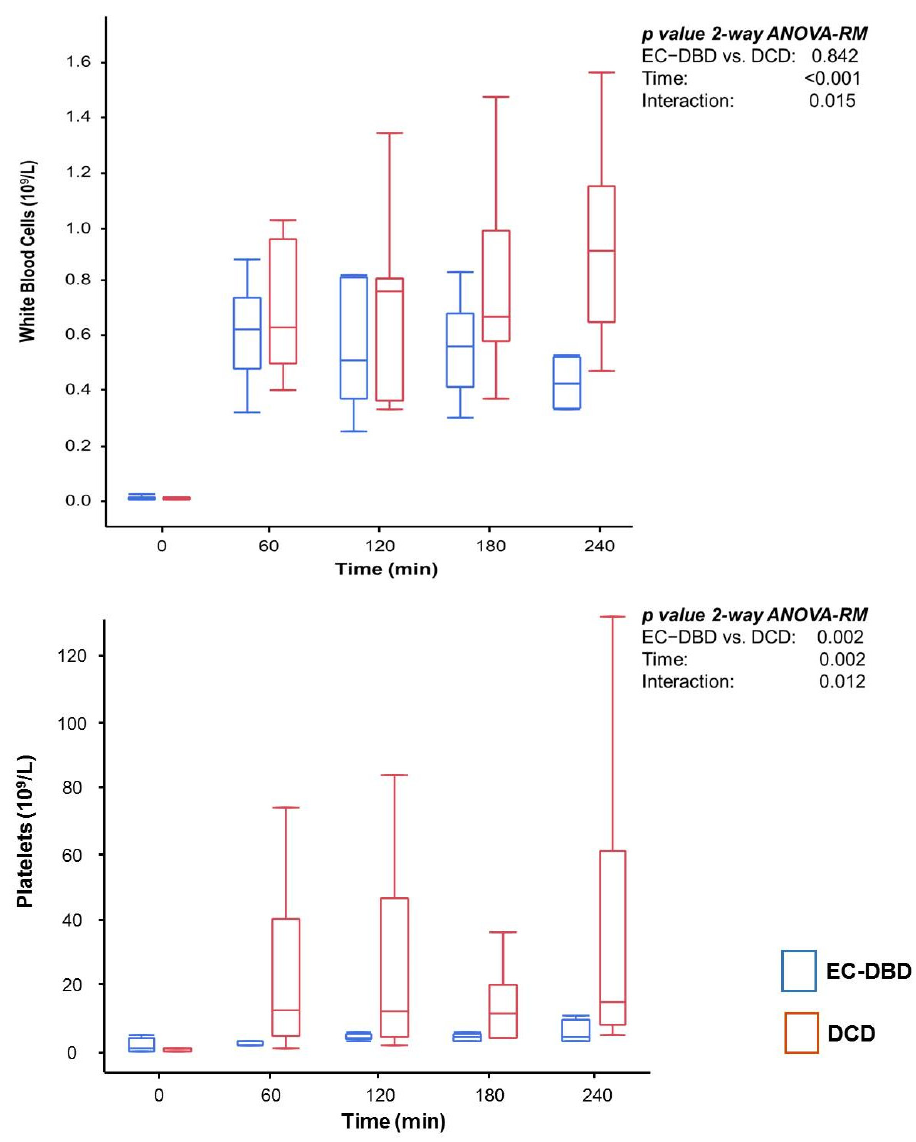
Figure 2. White Blood Cells and Platelets during EVLP. Appearance of white blood cells (WBC) and platelets in the EVLP perfusate of EC-DBD (blue) and DCD (red) grafts over 4 h of EVLP. No cellular blood components, other than erythrocytes, were present in the perfusate priming of the EVLP circuit. Similar levels of WBC appear immediately after graft reperfusion in both groups. Persistent WBC clearance occurs in the DCD grafts, but clearance decreases in the EC-DBD group. The “wash-out” of microthrombi in DCD graft leads to higher concentrations of platelets in the EVLP perfusate throughout the EVLP procedure. Statistics: two-way ANOVA-RM, p value < 0.05 was assumed as statistically significant.